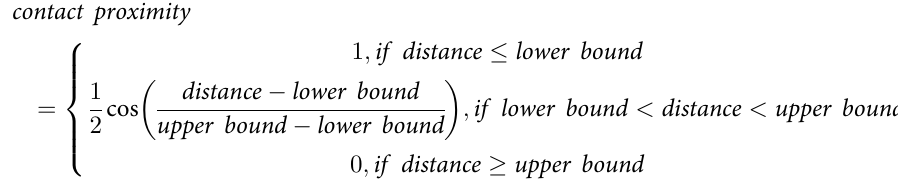
S1 Fig. Design native sequence recovery and mutation profile variability comparisons to PSI-BLAST profiles using relaxed and unminimized starting models. (A) Comparison of total native sequence recovery of relaxed and unminimized RECON MSD and SSD designs to PSI-BLAST sequence profiles generated using the native sequence. Asterisks indicate the